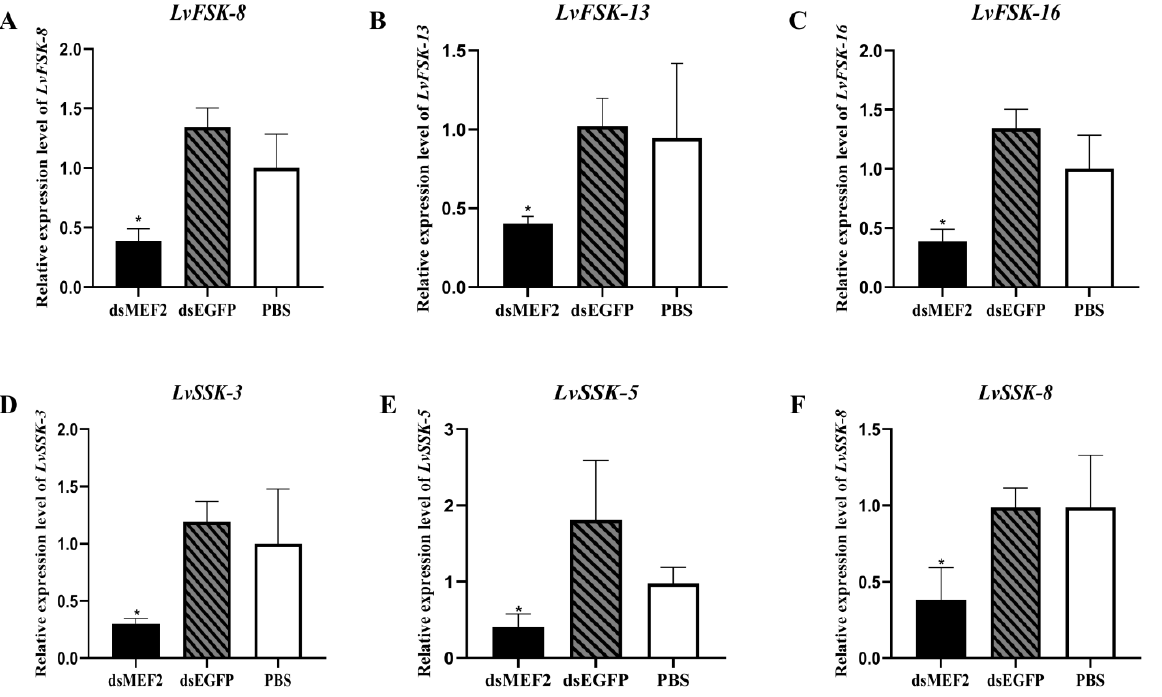
Figure 6. The expression of fast- and slow-type muscle genes after LvMEF2 RNA interference. ( A – C ) are fast-type skeletal muscle actin (FSK), LvFSK-8 , LvFSK-13 , and LvFSK-16 . ( D – F ) was slow-type skeletal muscle actin (SSK), LvSSK-3 , LvSSK-5 , and LvSSK-8 . Significant differences in the gene expression levels between three treatments are shown as * p <